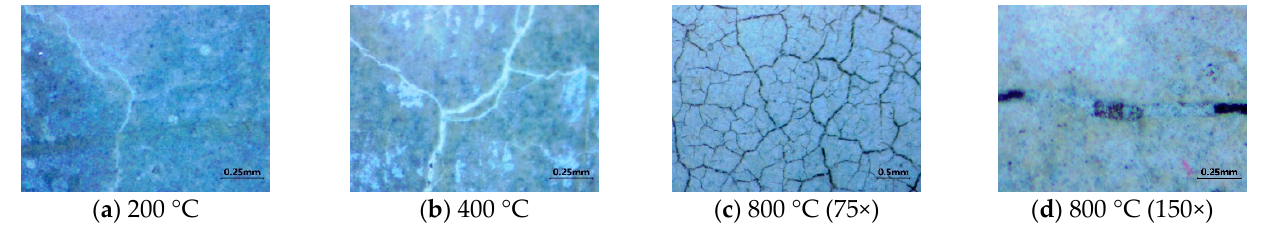
Figure 14. Surface condition after exposure to high temperatures and self-healing under clean water.